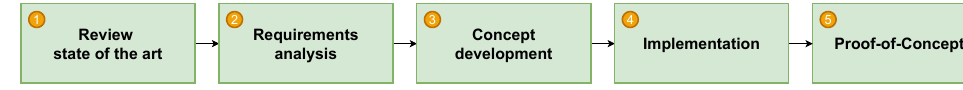
Figure 1. Proposed methodology for developing the toolchain